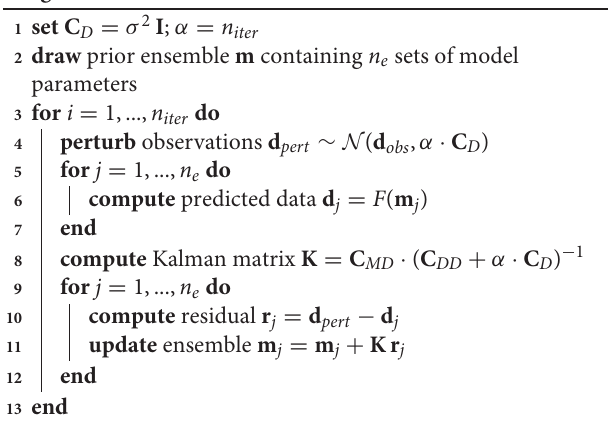
Algorithm 1: Standard